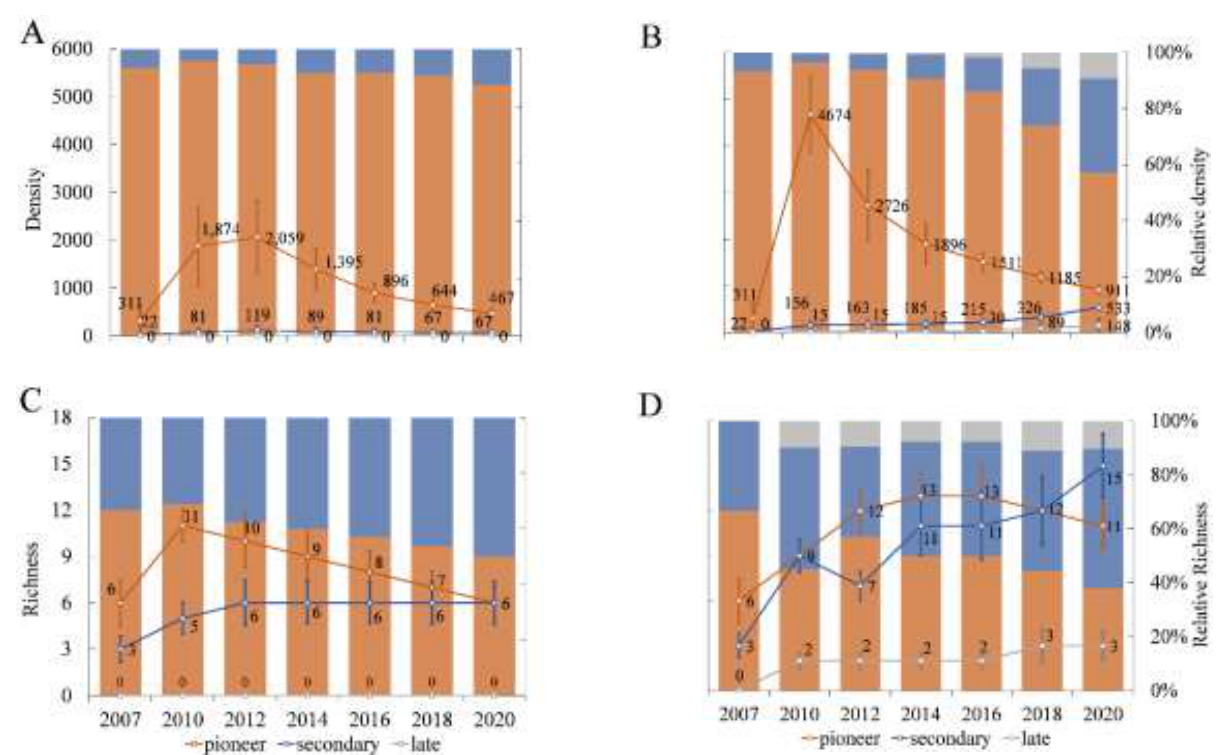
Figure 3. Density (no. trees.ha −1 , lines) and relative density (no. trees.ha −1 %, columns) for control ( A ) and removal ( B ), and richness (number of species — S, lines) and relative richness (% of number of species, columns) for control ( C ) and removal ( D ) for the different species successional groups. Bars around values represent standard deviations. Values for removal 2017 are from control as reference.